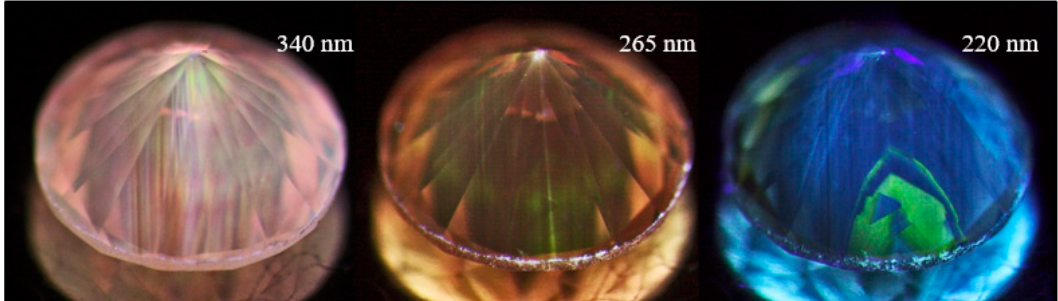
Figure 19. A light brown type IaA>B diamond (sample TH 2.435) under three different UV excitations of the DFI system. The images clearly show the defect distribution along the deformation-related slip planes along (111).